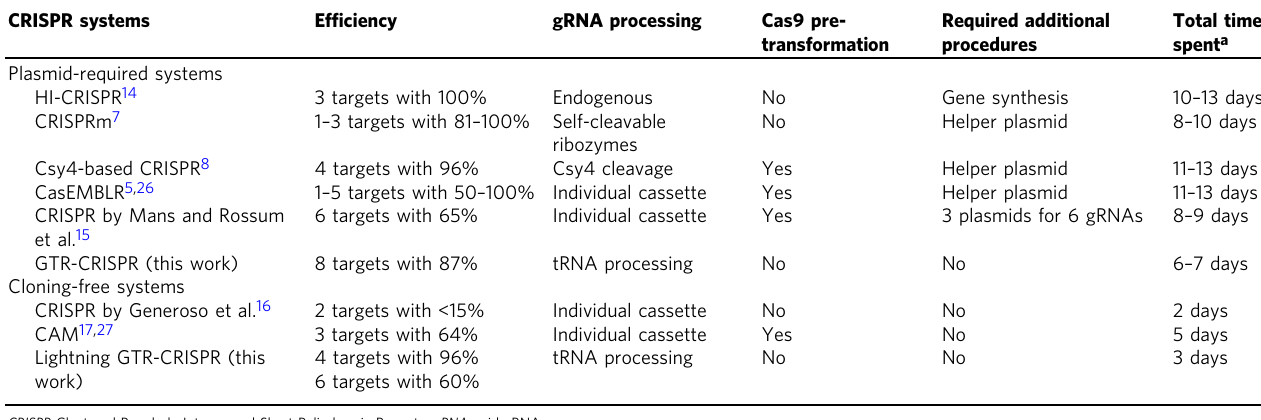
Table 1 Comparison of different CRISPR-Cas9-based multiplexed gene-editing systems CRISPR